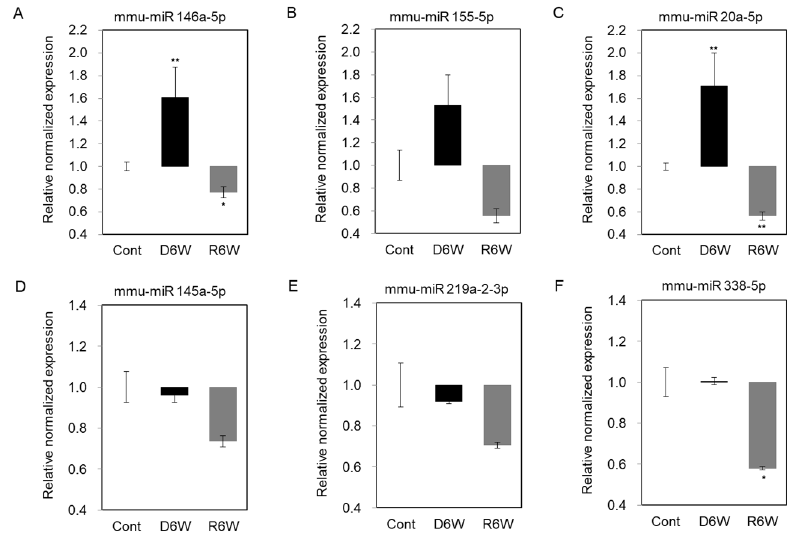
Figure 7. Validation of miRNA expression using miRNA quantitation Polymerization Chain Reation (PCR) in cuprizone-induced demyelination and remyelination mice. ( A – C ) The expression levels of miR 146a-5p, miR 155-5p, and miR 20a-5p were significantly upregulated in demyelinated mice (D6W) compared to control mice (Cont) by real-time PCR analysis. ( D , E ) The expression levels of miR 145a-5p and miR 219a-2-3p were weakly downregulated in D6W compared to Cont., but not miR 338-5p (F). n = 2, in triplicate for each group. The differences between groups are expressed as * p < 0.05, ** p < 0.01.